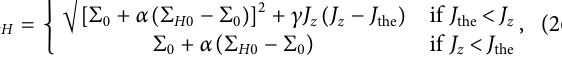
Frontiers in Astronomy and Space Sciences |